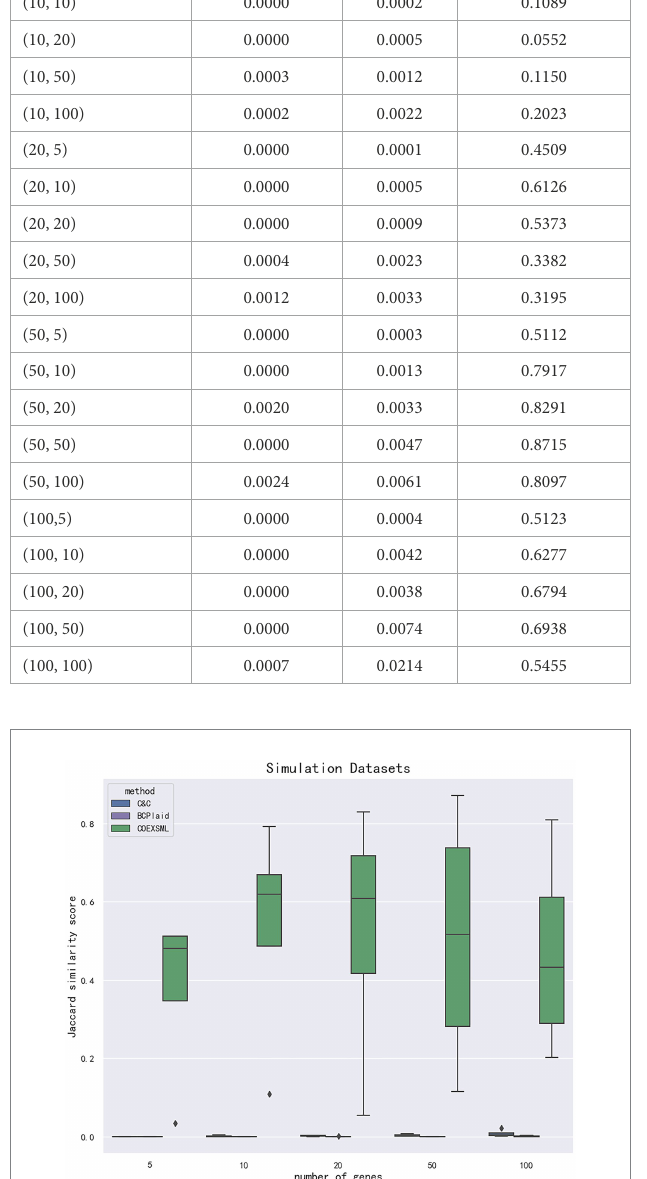
FIGURE 4 The data are divided according to the difference in the number of genes in the clusters in the simulated data set. The clustering effect is measured according to the jaccard similarity coefficient, and compared with other methods. COEXSML is the method proposed in this